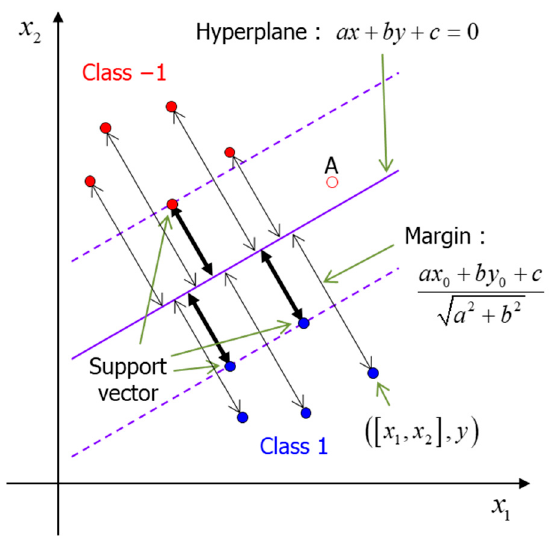
Figure 4. Linear